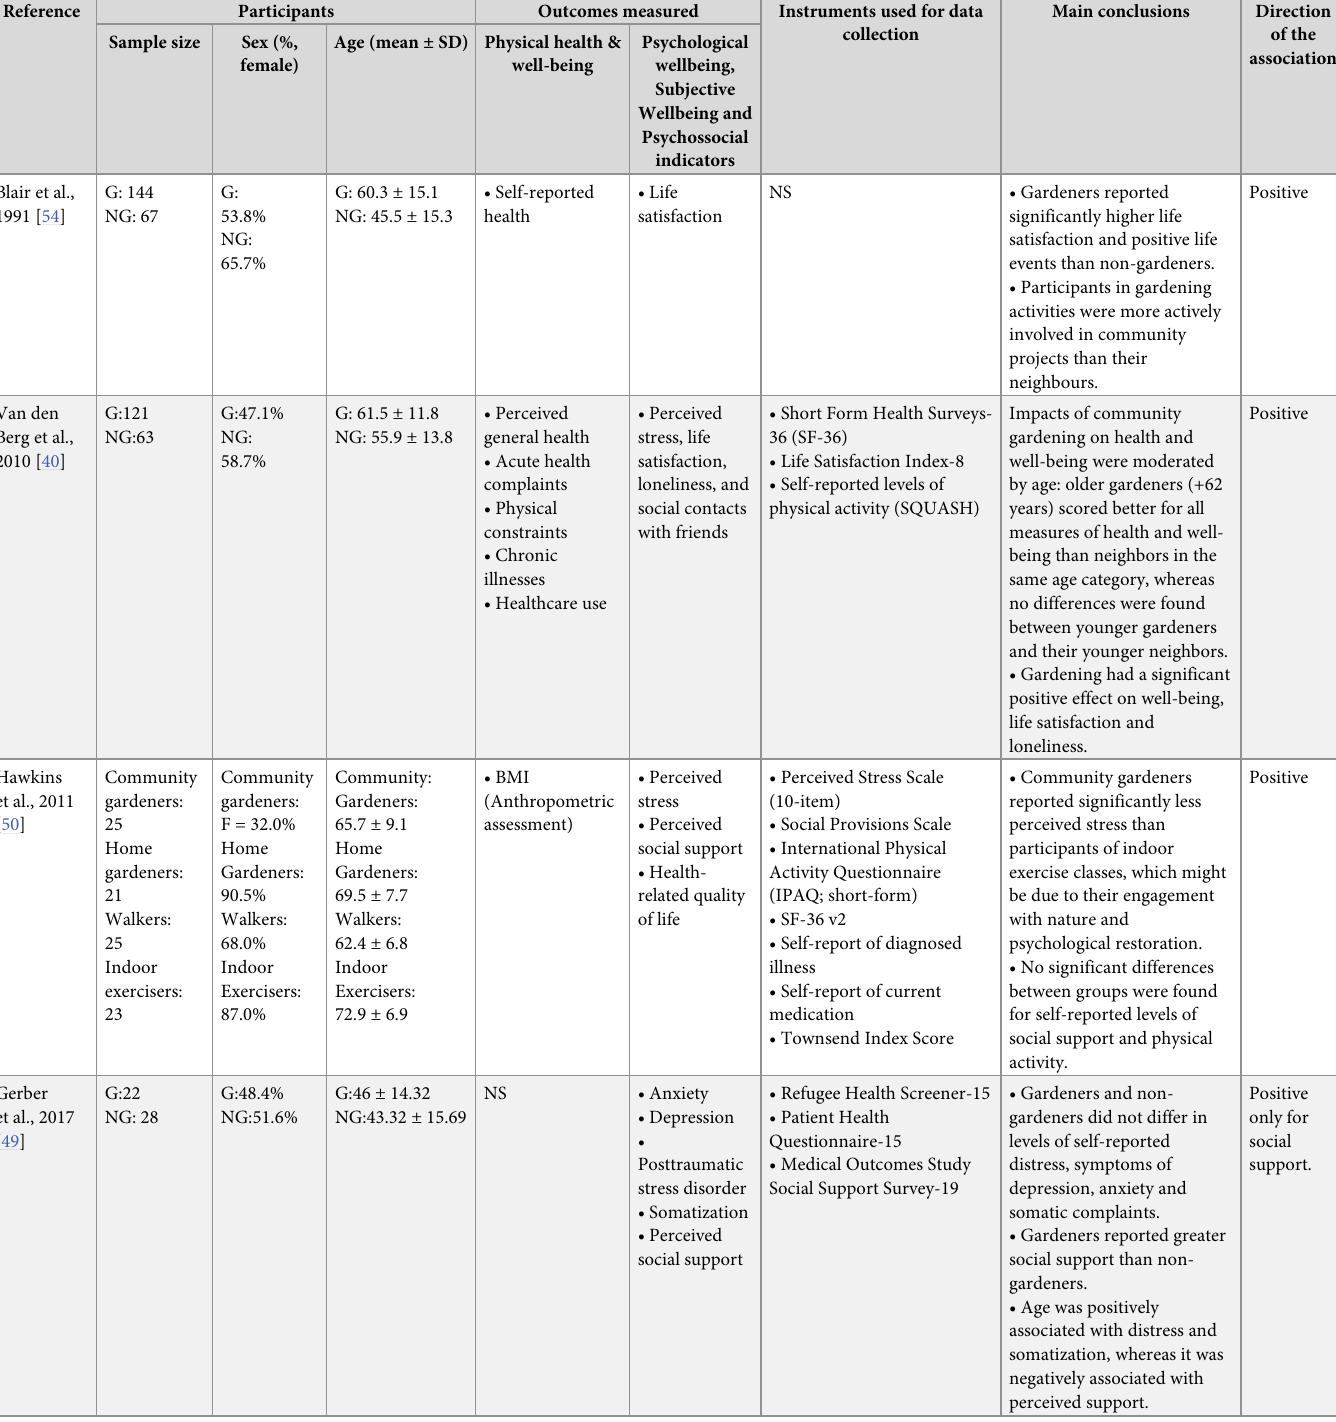
Table 2. Characteristics of the participants, i.e., gardeners (G) and non-gardeners (NG), outcomes and conclusions of the studies included in this systematic review of the literature.